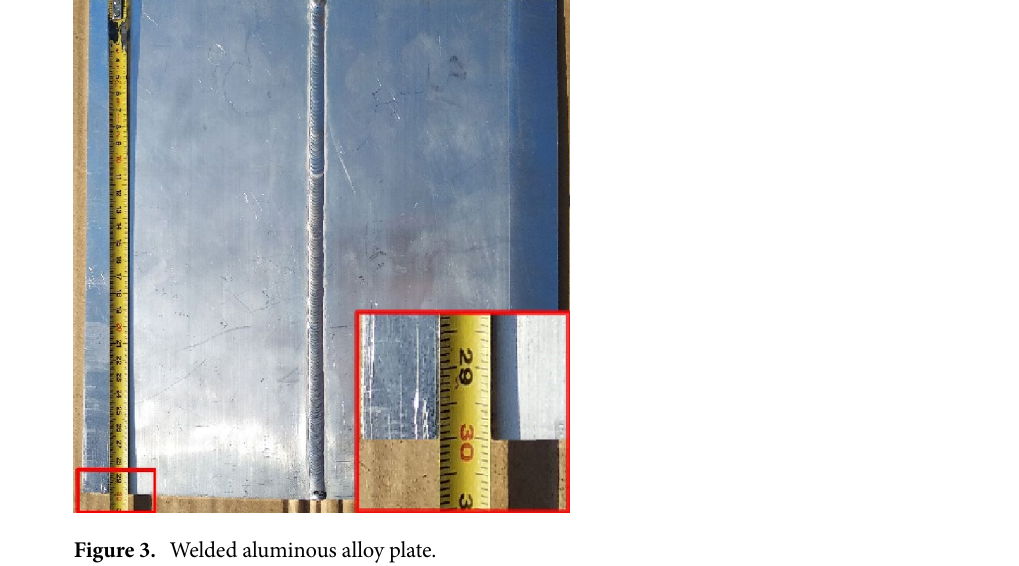
Figure 3. Welded aluminous alloy plate.